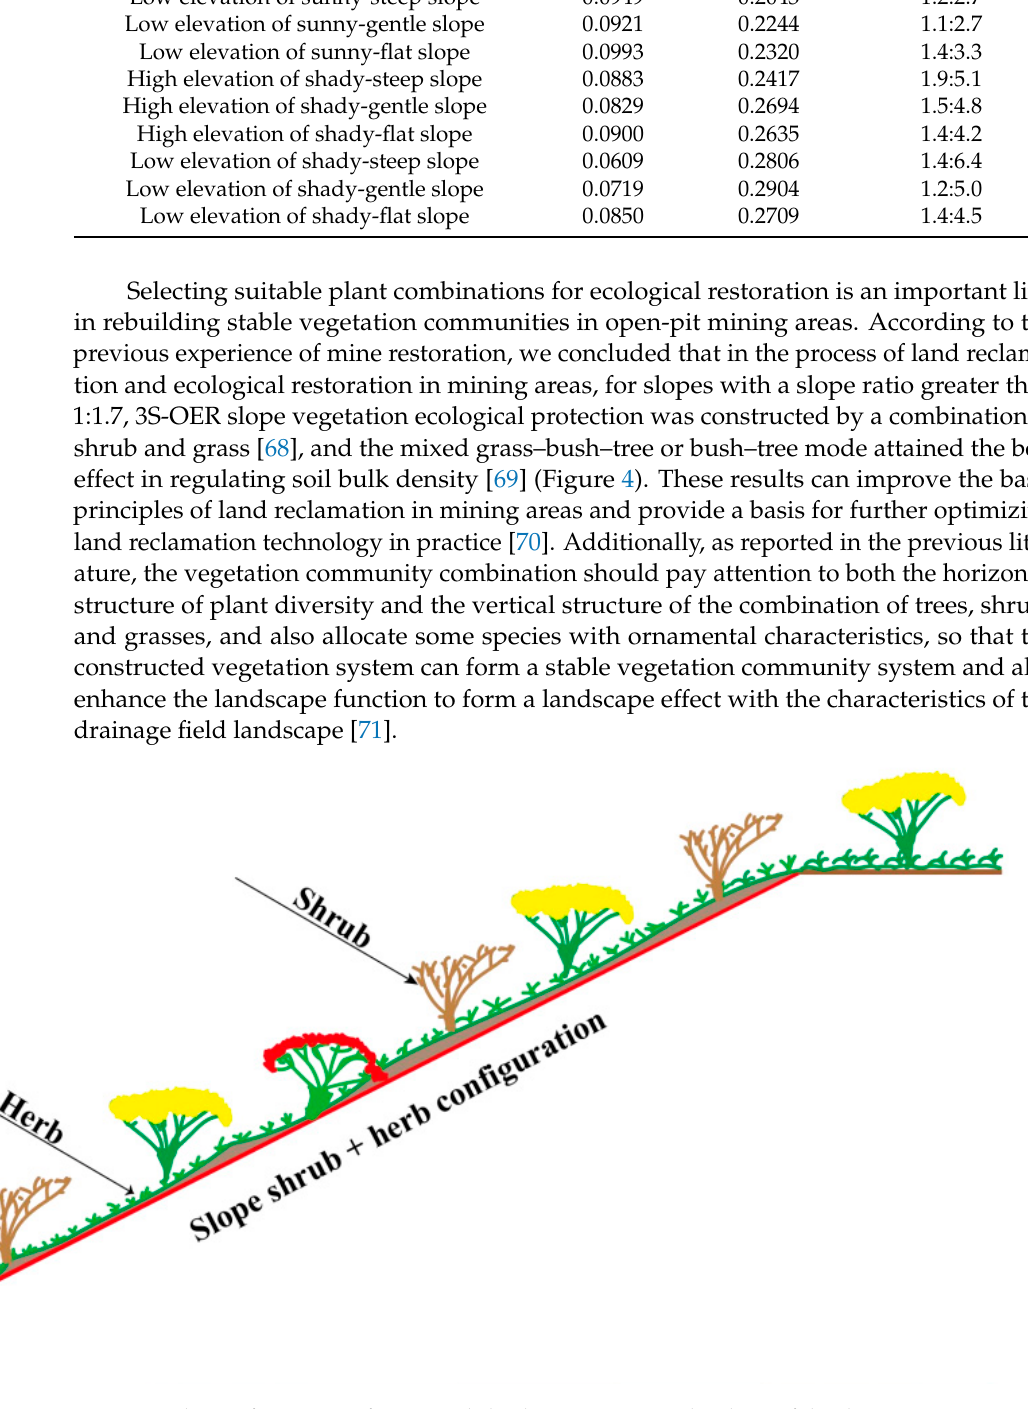
Figure 4. The configuration of grass and shrub vegetation on the slope of the dump.